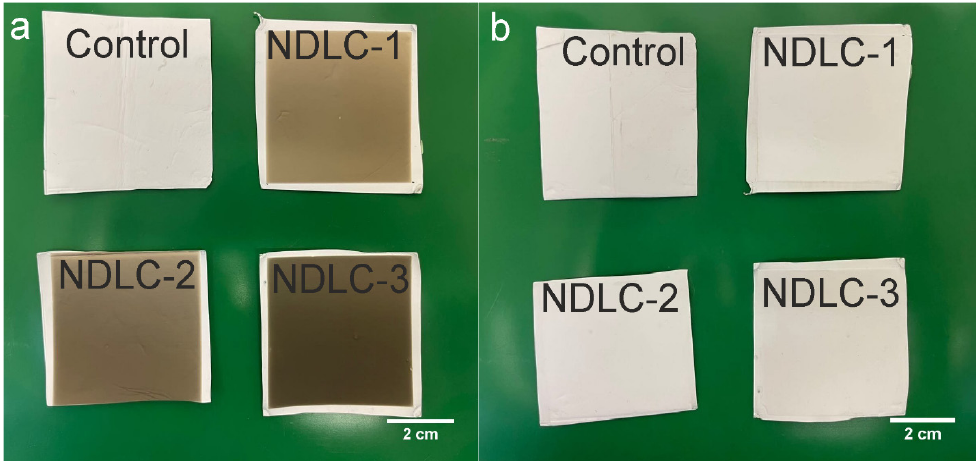
Figure 1. Front ( a ) and back ( b ) sides of the modified and unmodified materials. No melts or burns were observed on the front side of the scaffolds; thus, selected